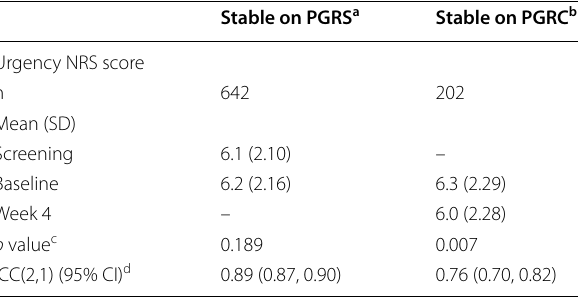
Table 2 Test–retest reliability of the urgency NRS